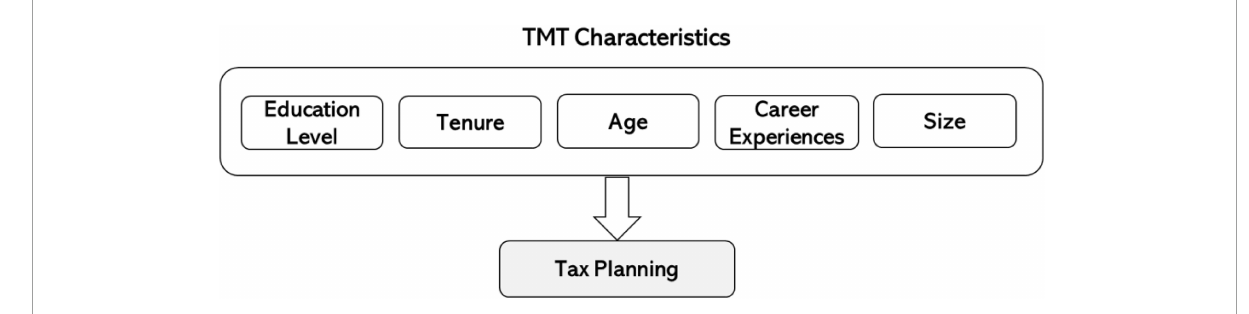
FIGURE1 The conceptual